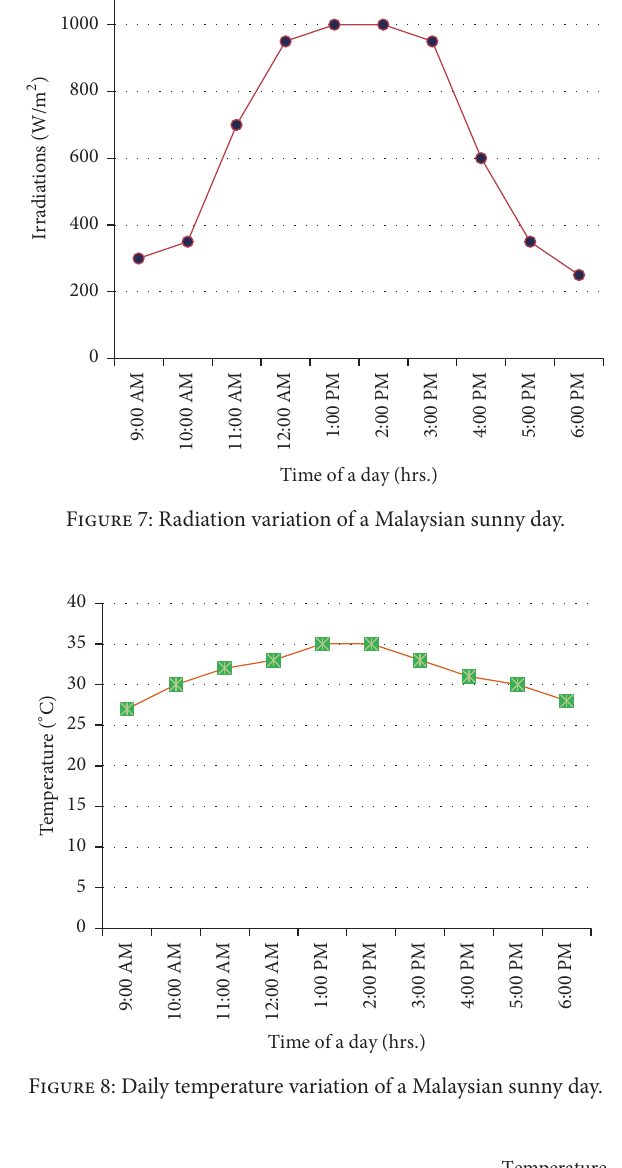
Temperature without PCM